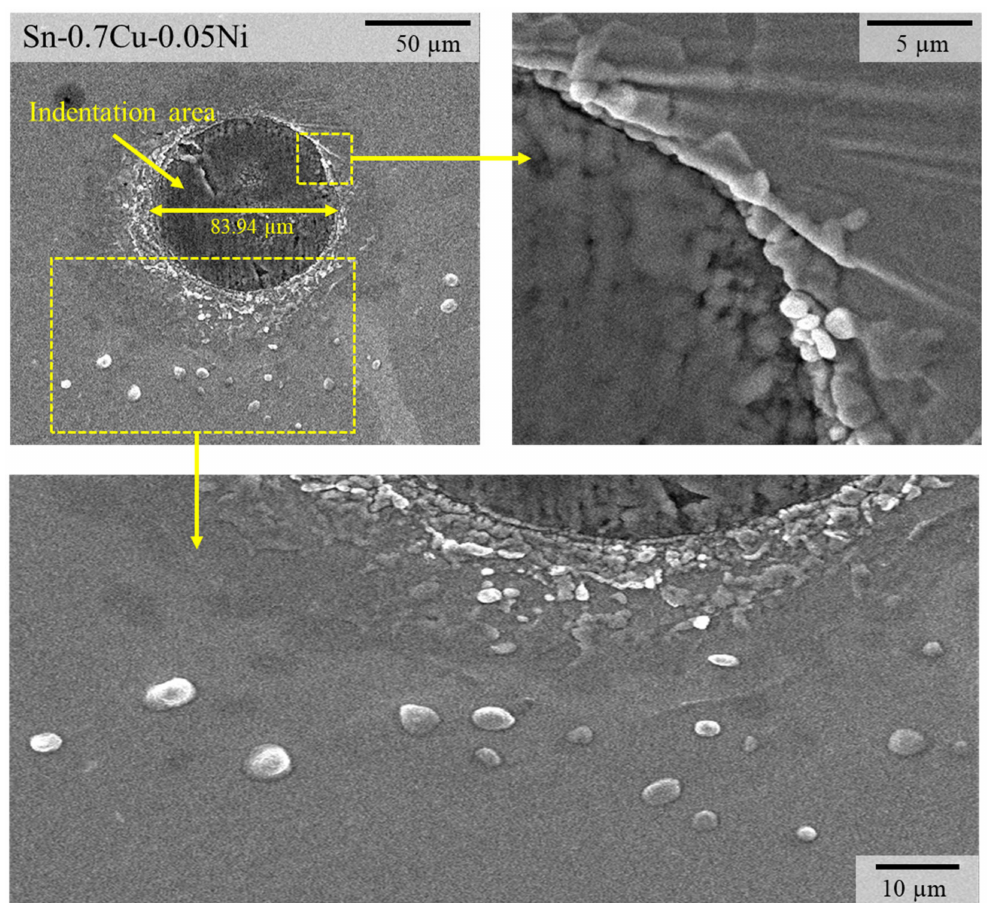
Figure 7. Scanning electron microscope (SEM) images of Sn whisker nucleation growth in the Sn-0.7Cu-0.05Ni solder joint after indentation for 12